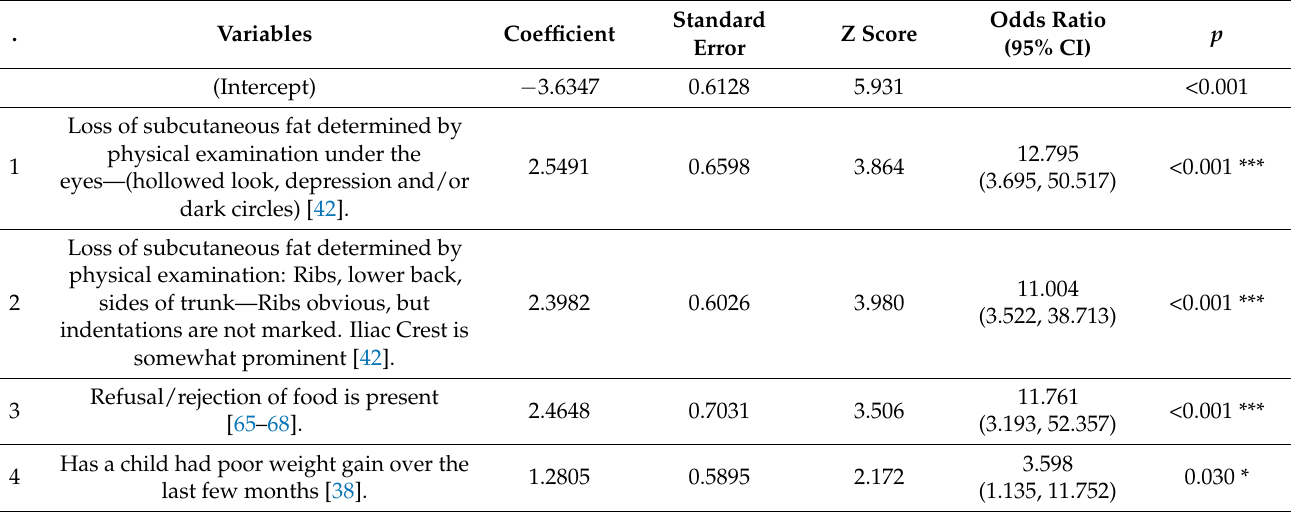
Table 1. Variables included in the